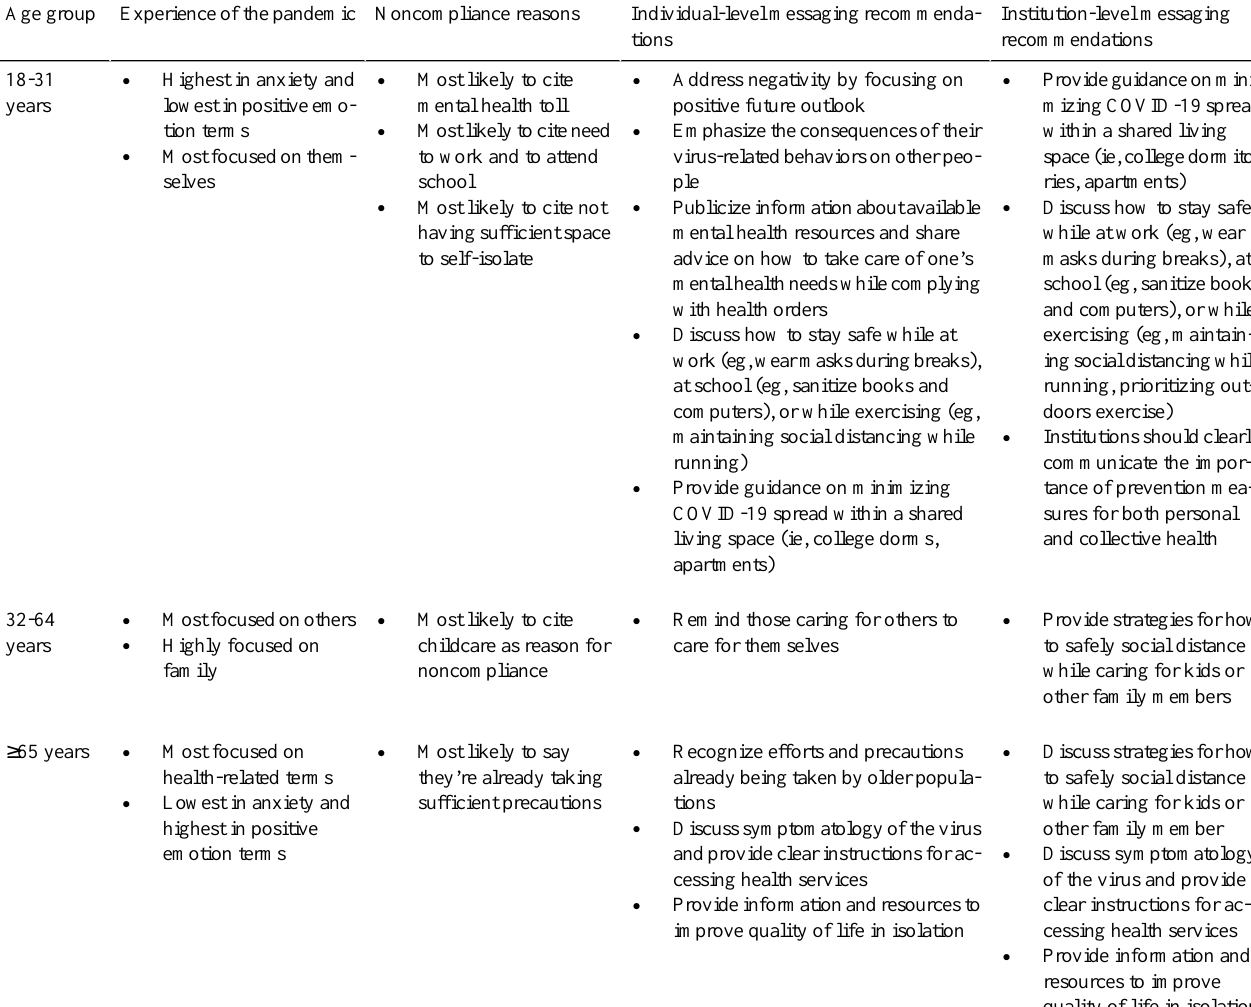
Table 3. Health communication strategies for COVID-19 messaging by age